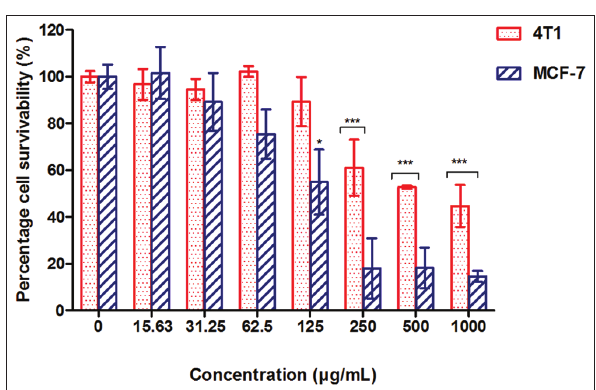
Figure-3: Cell survivability (%) of 4T1 and MCF-7 cancer cells following treatment with Syzygium polyanthum extract for 72